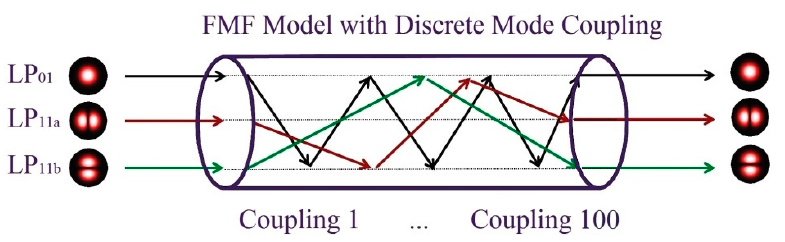
Figure 22. Schematic of spatial modes propagating in a FMF.